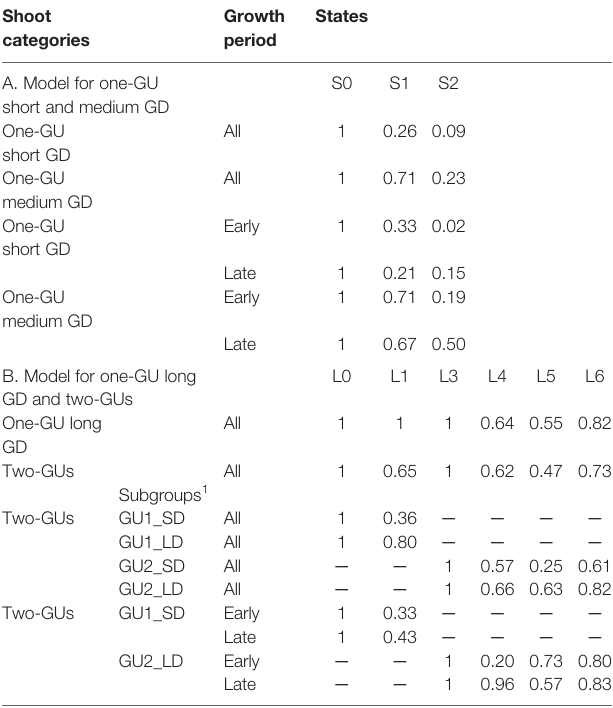
TABLE 2 | Occurrence probability of each branching zone for shoots grouped by growth cessation, growth duration (GD), and growth period. Shoot categories